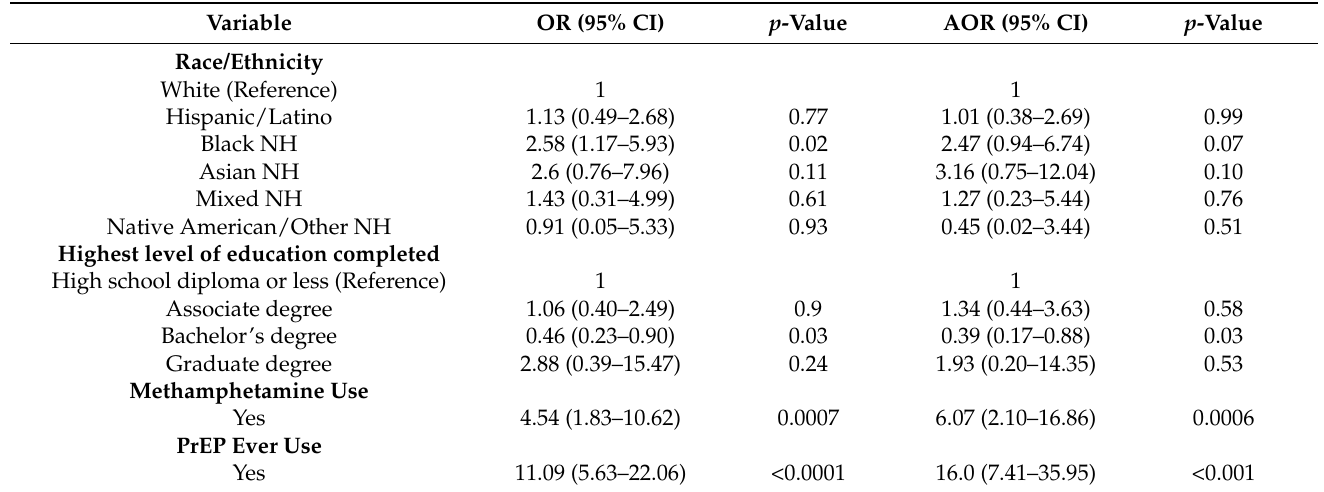
Table 3. Binary logistic regression examining associations between ever PEP use and individual characteristics, PrEP use, and methamphetamine